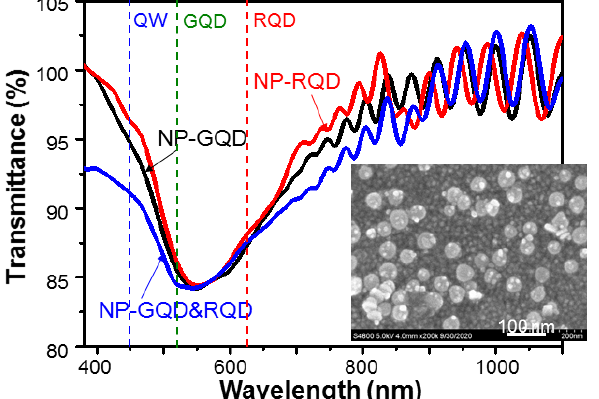
Figure 7. Transmission spectra of the surface structures in samples NP-GQD, NP-RQD, and NP- GQD&RQD. The vertical dashed lines show the emission wavelengths of the QWs of the LED, GQDs, and RQDs. The insert shows the SEM image of sample NP-GQD&RQD.